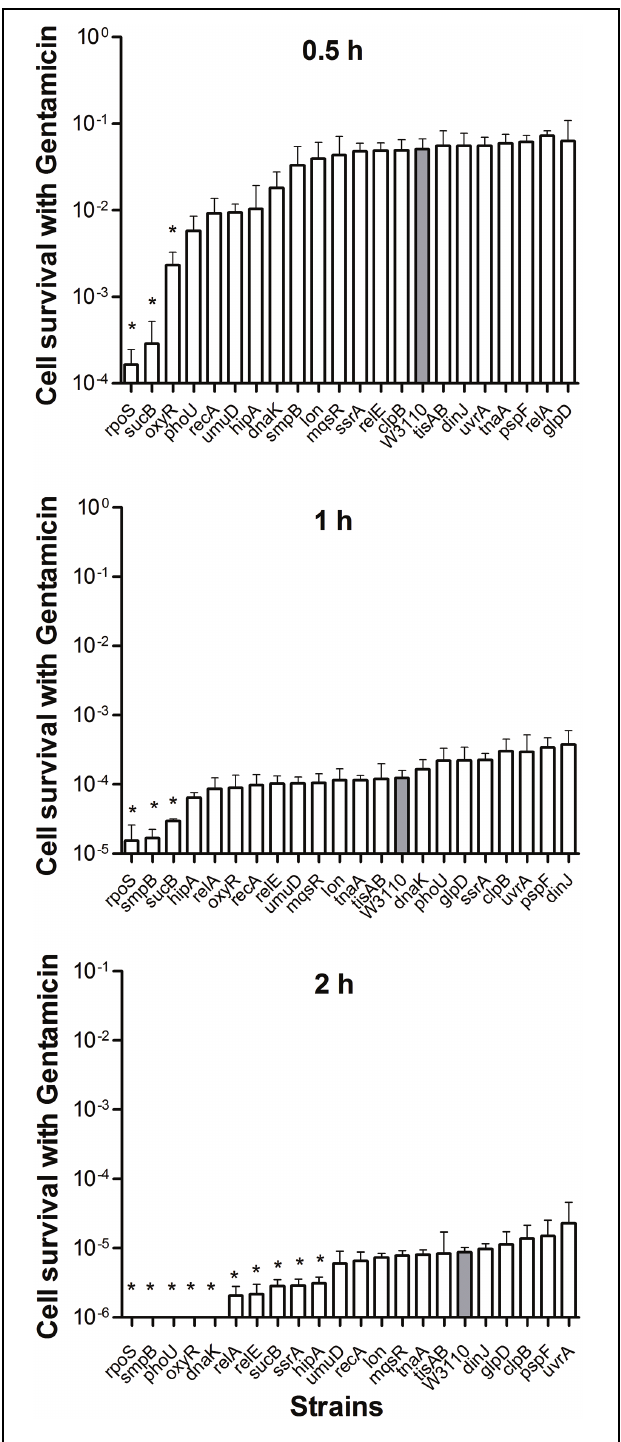
FIGURE 3 | Deletion mutant ranking depends on cell survival over time under conditions of gentamicin exposure. Stationary phase cultures of W3110 and single-gene mutants were diluted 100-fold and exposed to 20 μ g/ml gentamicin for 0.5, 1, and 2 h. The data for each mutant was plotted and compared with that of W3110. Error bars indicate the standard deviation ( n = 3). The asterisk indicates statistical significance as determined using Mann–Whitney U tests ( ∗ P <